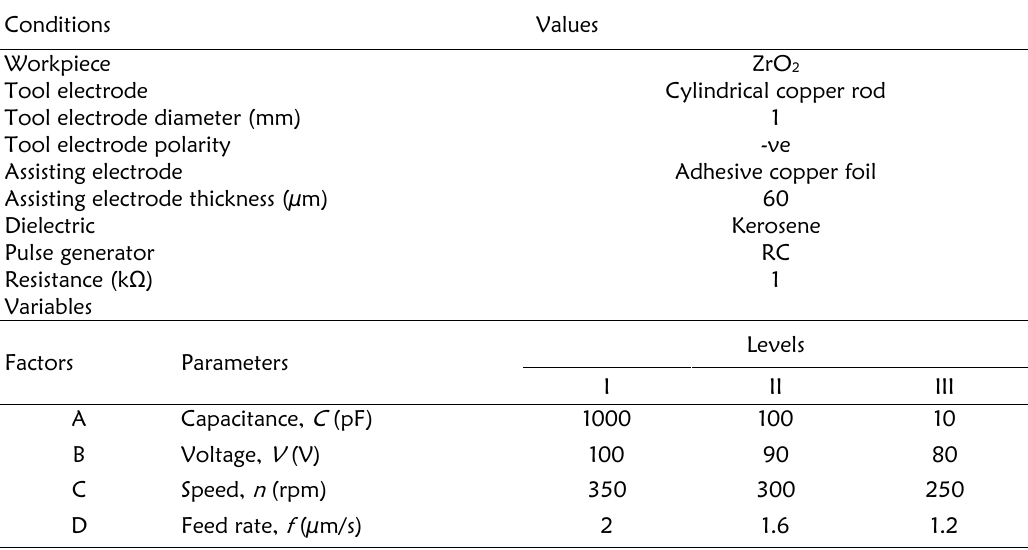
Table Error! No text of specified style in document.1 Experimental